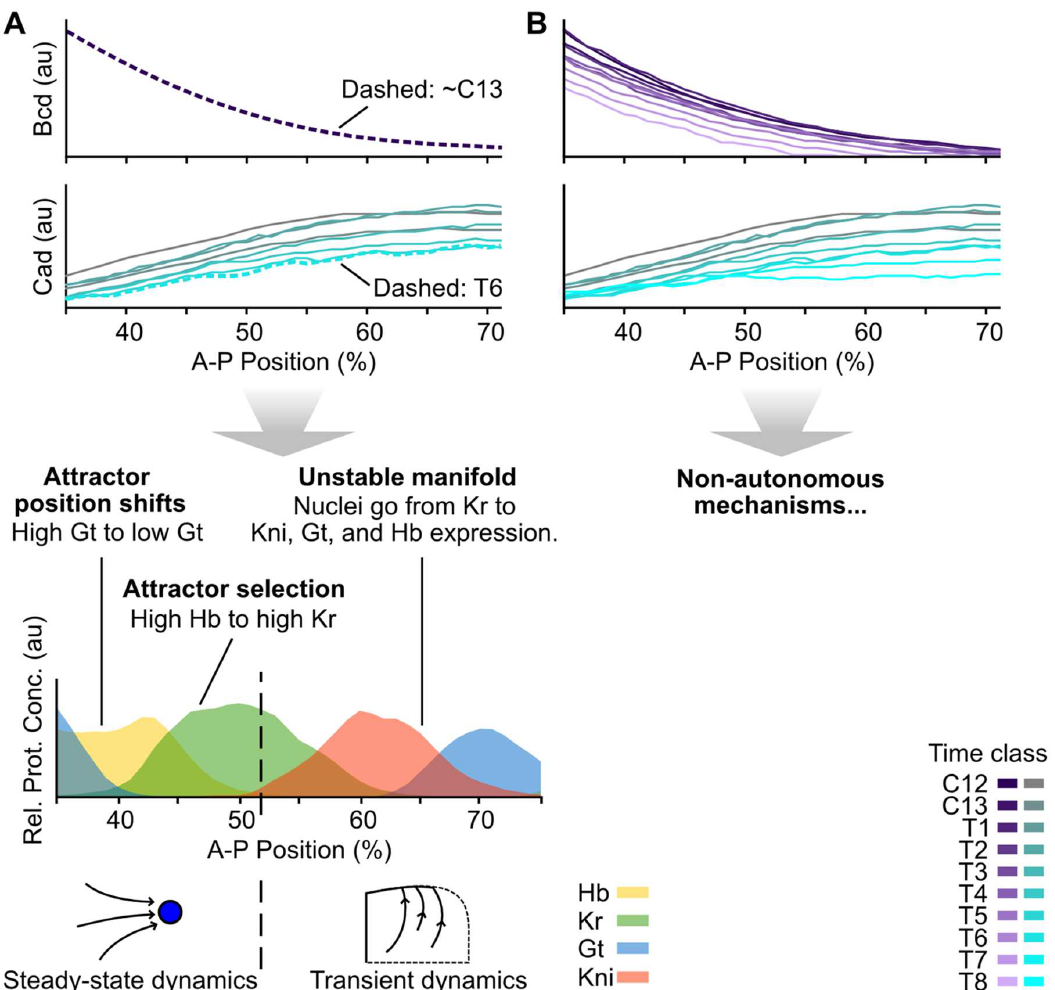
Fig 2. Static-Bcd versus non-autonomous gap gene patterning mechanisms. (A) Summary of the phase space analysisof the Static-Bcd gap gene circuit in D. melanogaster by Manu et. al . [23]. An exponential function fit to the Bcd profile at cycle C13 was used to calculatetrajectories and phase portraits. All Cad profilesuntil time class T6 were considered for simulatingtrajectories, but phase portraits were calculatedusing the profile at T6 only. This gene circuit displaysthe followingmechanisms for boundaryformation: patterning between 35–51%A–P position takes place in a multi-stable regime close to steady state. The Gt boundaryis established as the relevant attractor moves from high to low Gt concentration in more posterior nuclei.The Hb-Kr interface forms as the maternalHb gradientplaces more anterior nuclei in the basin of an attractor with high Hb concentration, and more posterior nuclei in the basin of an attractor at high Kr concentration. Between51 and 53% A–P position a saddle-node bifurcationtakes place, and the dynamicsbecome transient in nucleiposterior of 52%. These nucleiare all in the basin of the same attractor and approachit by first converging towards an unstable manifold.Anterior shifts in these posterior gap gene domainsemerge from a coordinated succession of trajectoriesin more posterior nucleiapproachingthe unstablemanifold.See [23] for details. (B) In the non- autonomous gap gene circuit analysedhere, Bcd and Cad gradientprofiles are includedfor every time point. They are used to calculate trajectories of the system and instantaneous phase portraits as discussedin the main text. Plots in (A) and (B) show % A–P position along the x-axes, and protein concentrations (in arbitrary units, au) along the y-axes as in Fig 1B).